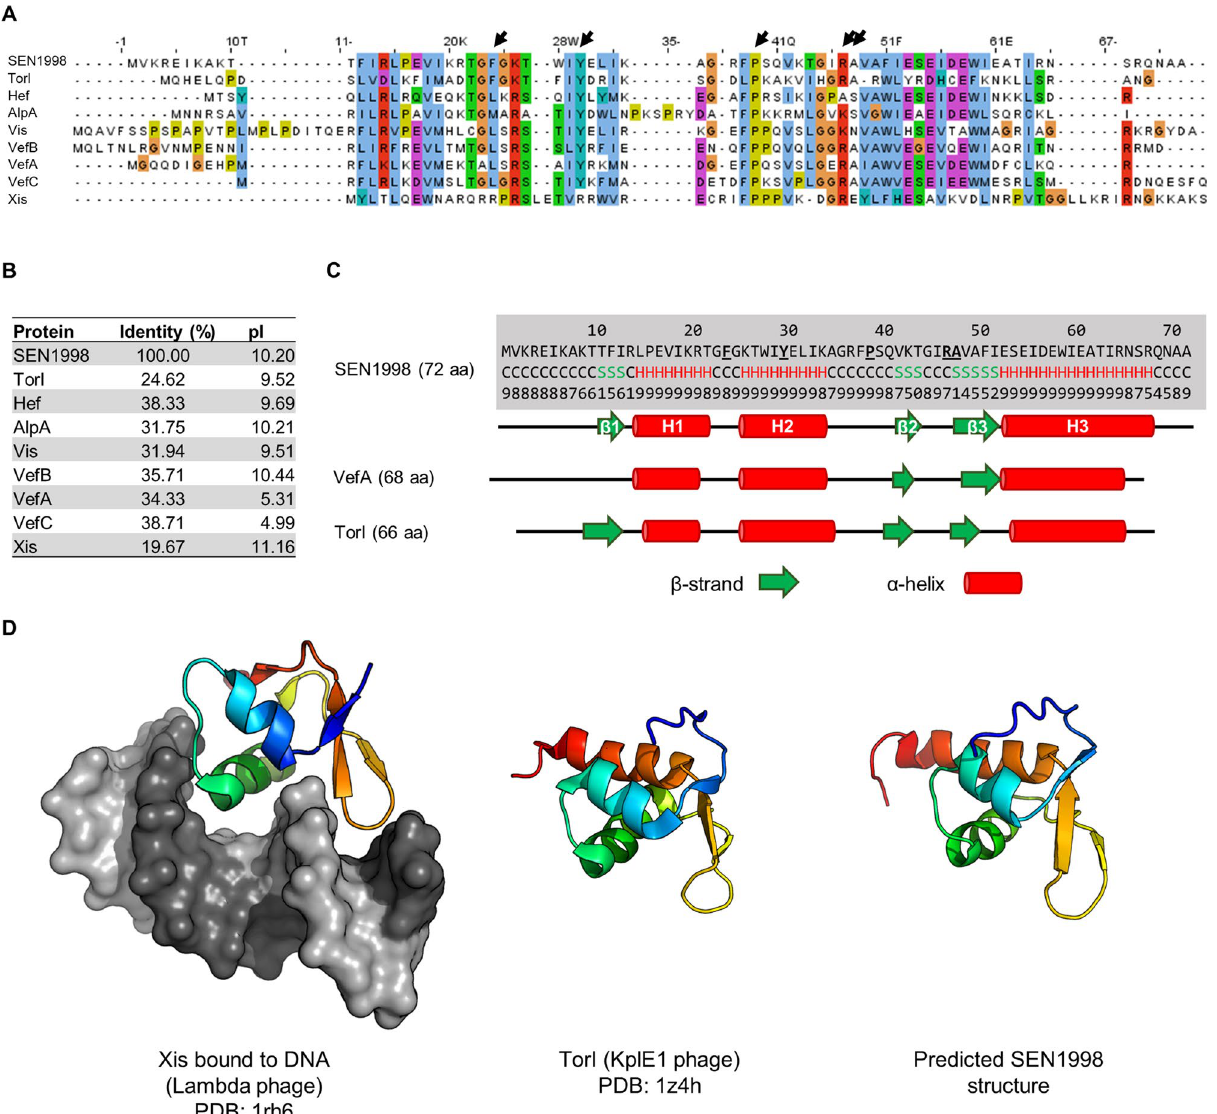
Figure 3. The gene SEN1998 of ROD21 encodes a putative recombination directionality factor. ( A ) Multiple sequence alignment of the amino acid sequence of SEN1998 and characterized RDFs from phage (TorI, AlpA, Vis and Xis) and GI (Hef, VefA, VefB and VefC) origin. Conserved residues are colored according to the ClustalX coloring scheme. The black arrows indicate the conserved residues that has been recognized as important for the RDF function of TorI. ( B ) Percent identity of the aligned proteins regarding SEN1998, and isoelectric point. ( C ) Comparison of the secondary structures of SEN1998 (predicted), VefA (predicted) 33 , and TorI (experimentally determined) 35 . ( D ) Tertiary structures of the RDFs: Xis bound to DNA, (experimentally determined) 34 ; TorI (experimentally determined) 35 and SEN1998